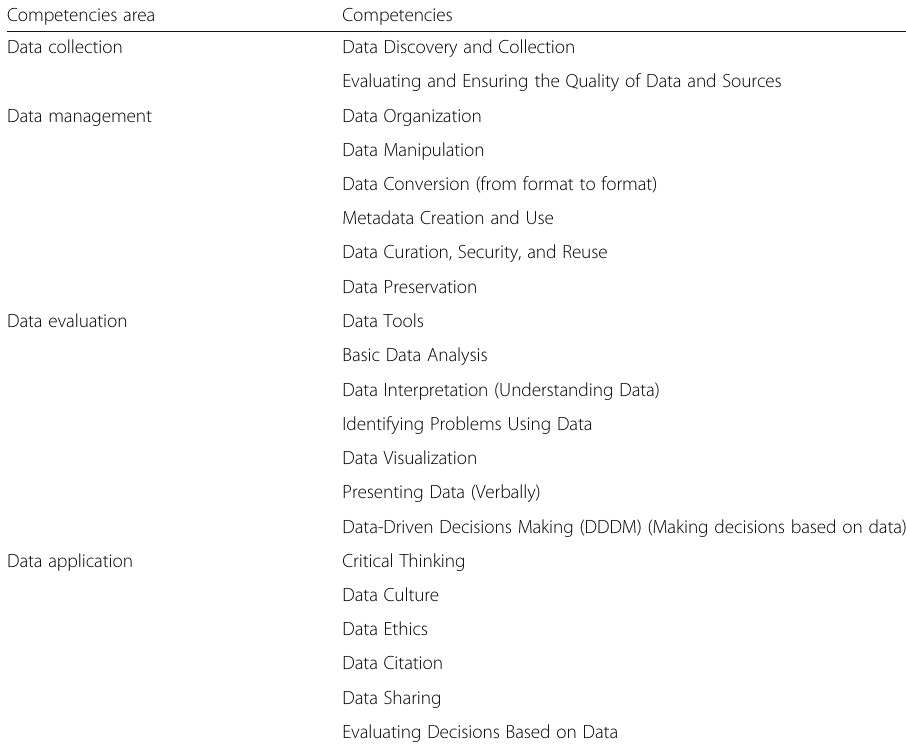
Table 1 A data literacy competencies matrix (Ridsdale et al., 2015) Competencies